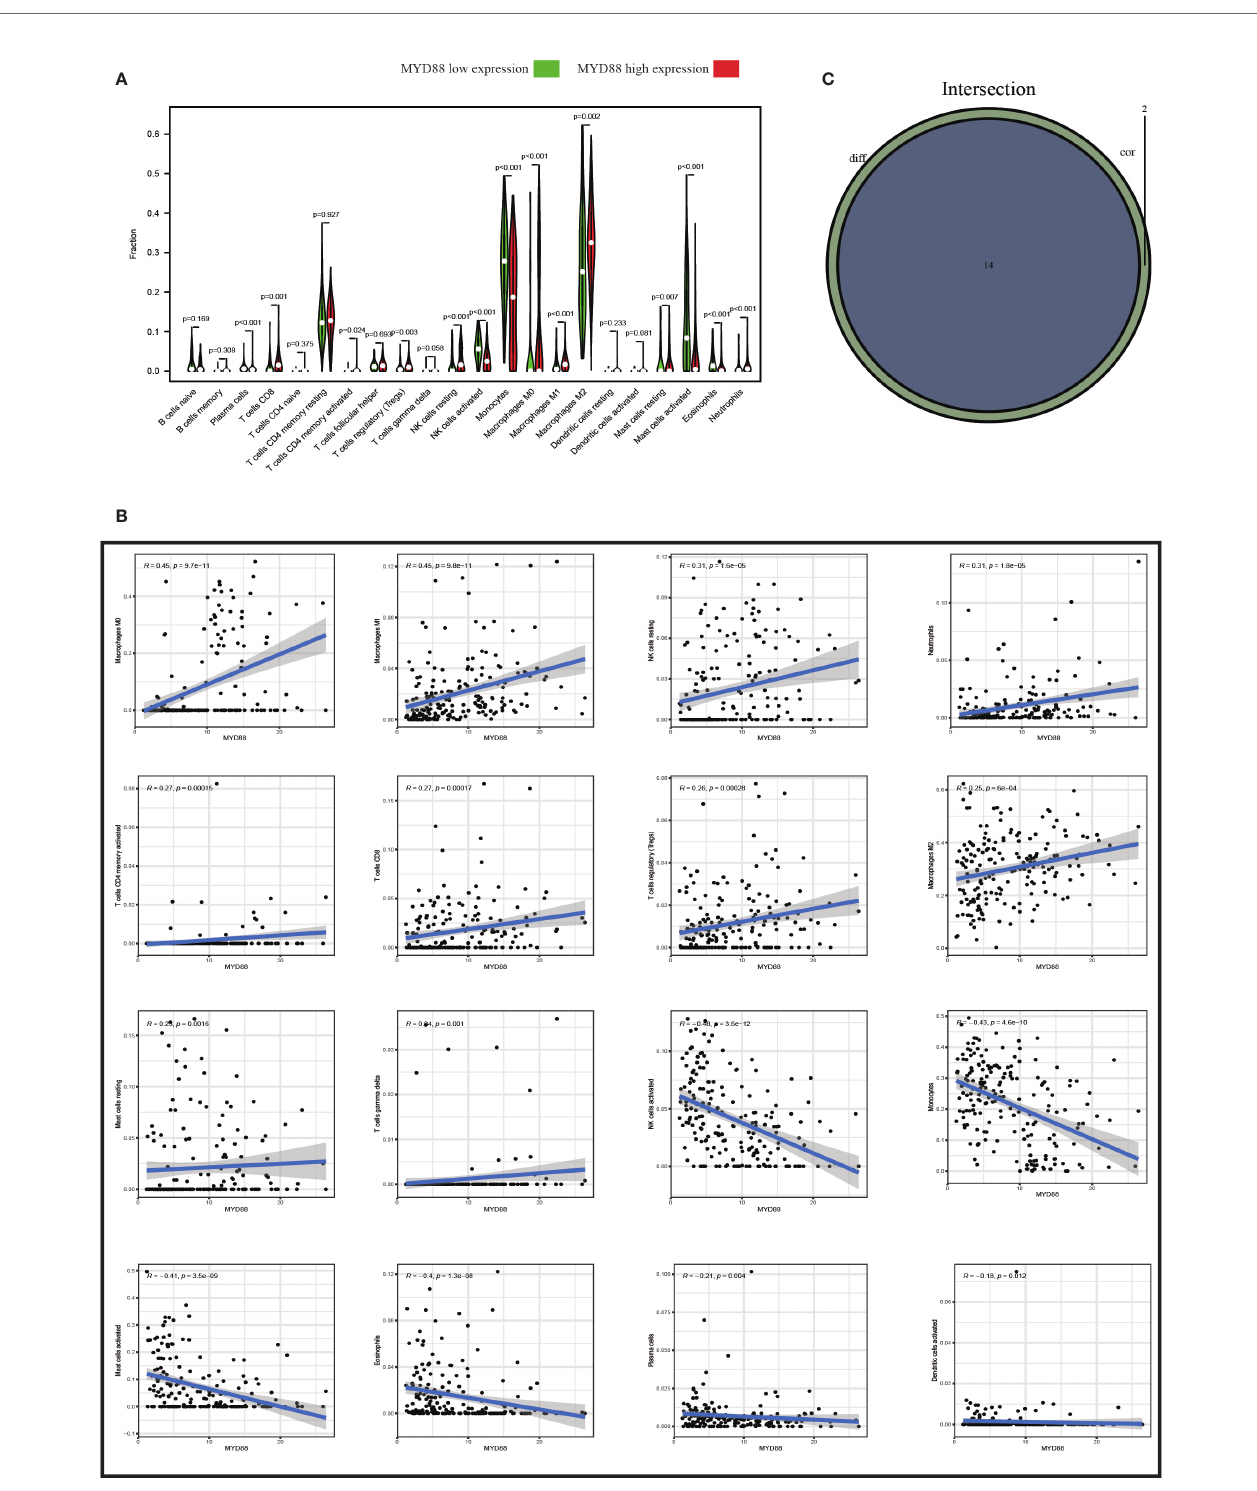
FIGURE 6 | MYD88 was associated with the TIICs of TME in glioma patients. (A) The Macrophage M0, Macrophage M1 and Macrophage M2 were signi fi cantly up- regulated in MYD88 high-expression group. However, the Monocytes, Mast cells activated and Eosinophils were signi fi cantly up-regulated in MYD88 low-expression group. (B) The MYD88 expression was positively associated with Macrophage M0, Macrophage M1, and Macrophage M2. And MYD88 was negatively correlated with NK cell activated, Monocytes and Mast cells activated. (C) Intersection analysis showed that 14 TIICs were signi fi cantly associated with MYD88 expressions using both difference and correlation